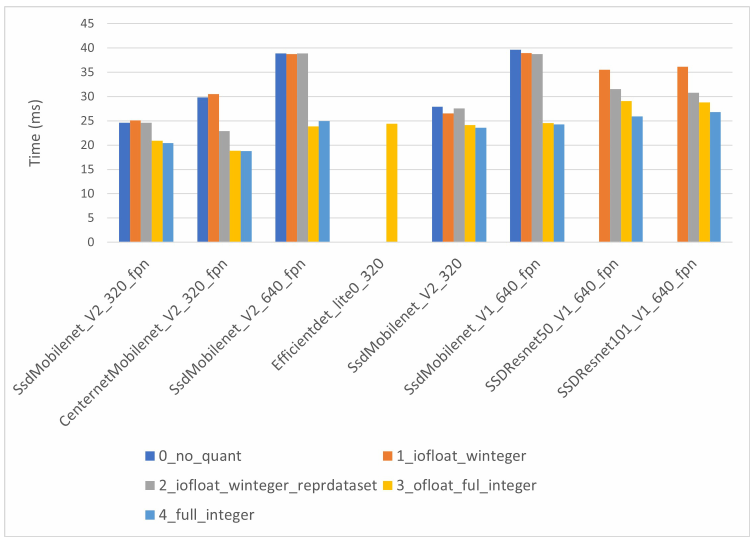
Figure 15. i-MX8M-PLUS auxiliary processing